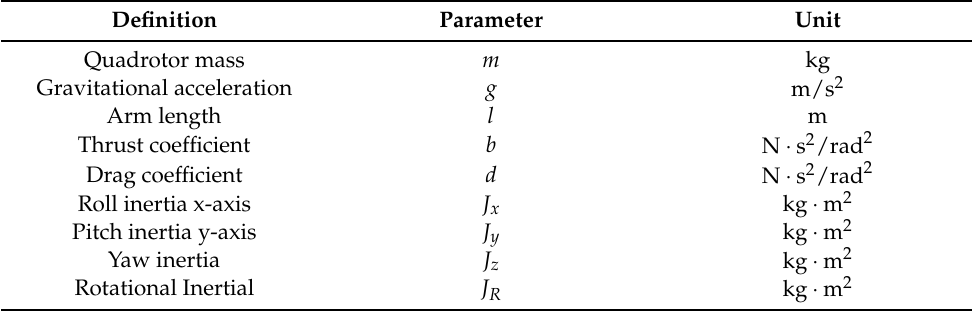
Table 1. Quadrotor